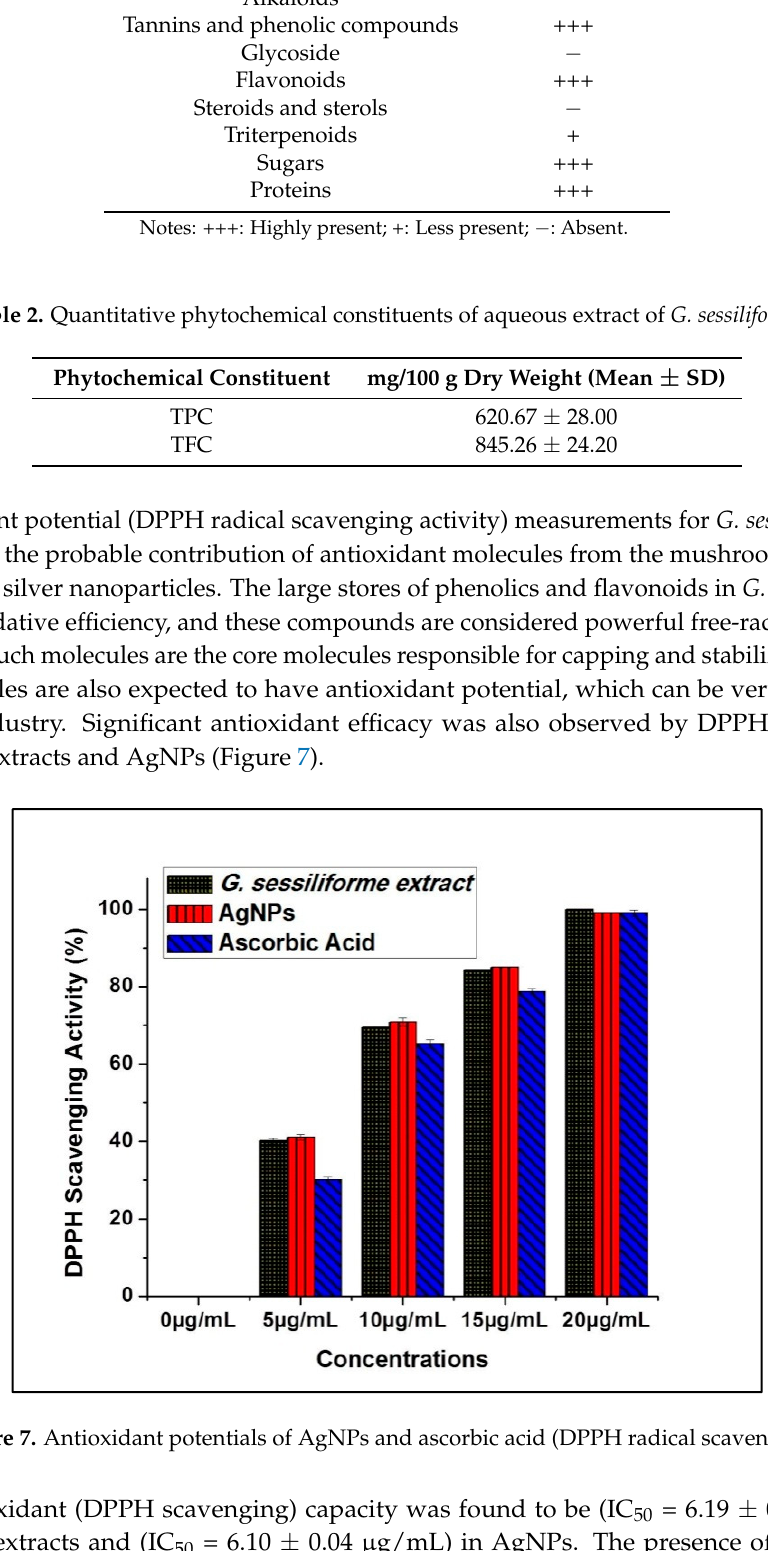
Table 1. Qualitative phytochemical screening of aqueous extract of G. sessiliforme .